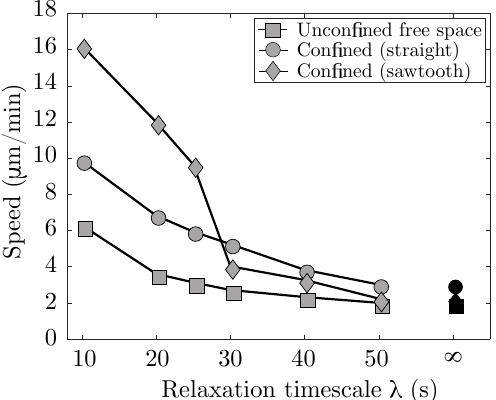
Figure 7. Confinement enhances locomotion speed. Cell speed as a function of strain relaxation timescale for actin turnover, λ . Three physical environments are considered: cell placed in free space (unconfined), a straight rigid channel with channel width of 13 µ m (confined), and an asymmetric rigid channel with a low amplitude, high frequency sawtooth top channel and a straight bottom channel. Each data point represents the speed computed from a linear fit over four full cycles of the horizontal displacement of the cell centroid. The result for no actin turnover (i.e., an elastic cortex) is for λ → ∞